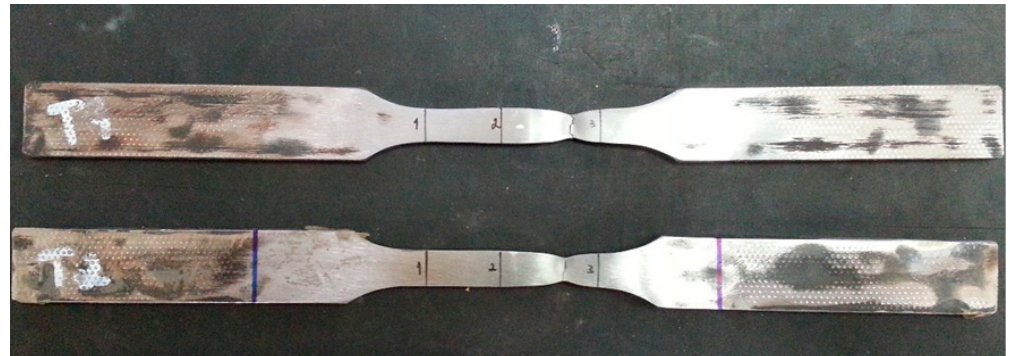
Figure 8. Aspect of the samples used in tensile tests after rupture. Line 2 indicates the welding zone. Table 9. Yield strength, ultimate tensile strength, and elongation at room and high temperature. Samples